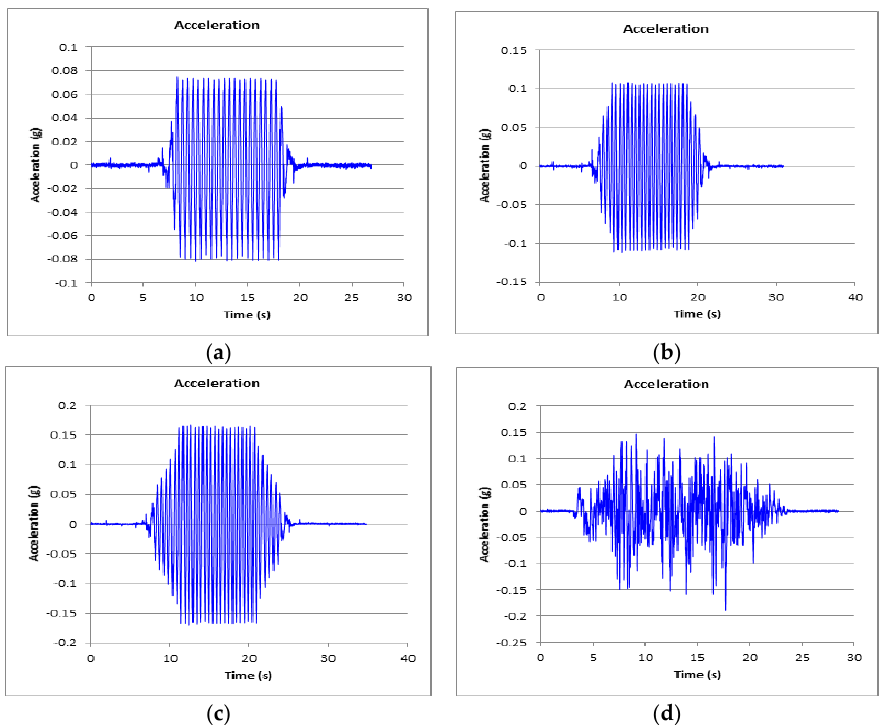
Figure 5. Input motion: ( a ) Sine wave 2 Hz, PGA 0.07 g; ( b ) Sine wave 2 Hz, PGA 0.1 g; ( c ) Sine wave 2 Hz, PGA 0.154 g; ( d ) Artificial seismic wave, PGA 0.18 g. 2 Hz, PGA 0.154 g; ( d ) Artificial seismic wave, PGA 0.18